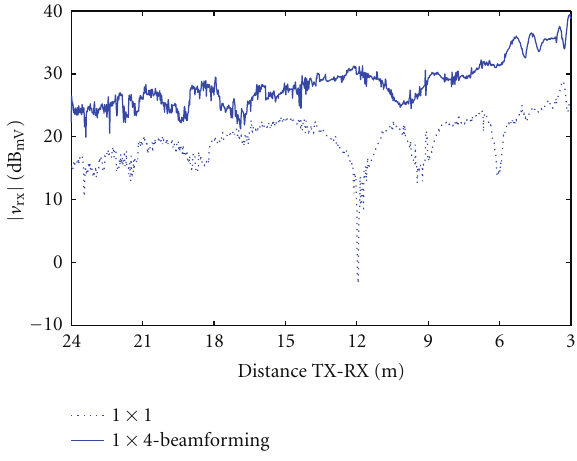
Figure 8: Amplitude of the signal received by the array after beamforming (full line) versus the amplitude of the signal received by a single patch antenna (dotted line), as a function of distance to the transmit antenna.